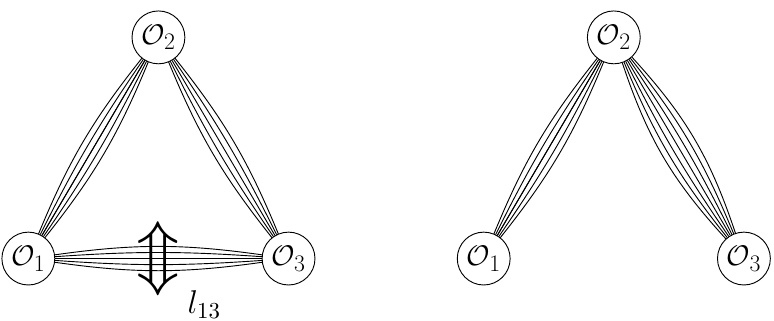
Figure 2 . Generic versus extremal three-point functions. The second type can be removed by redefining O ’s to be orthogonal to double-trace